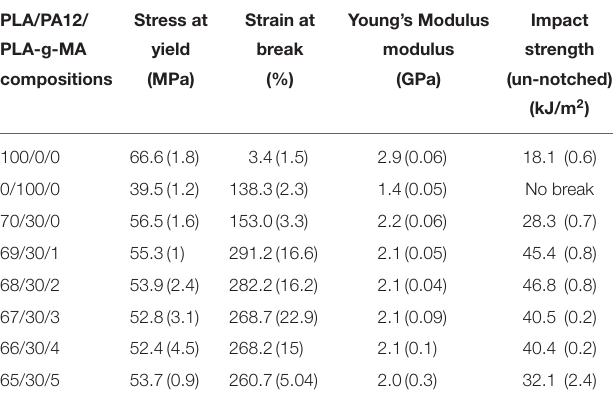
TABLE 1 | Stress at yield, strain at break, and impact strength for as-produced PLA/PA12/PLA-g-MA blends. PLA/PA12/